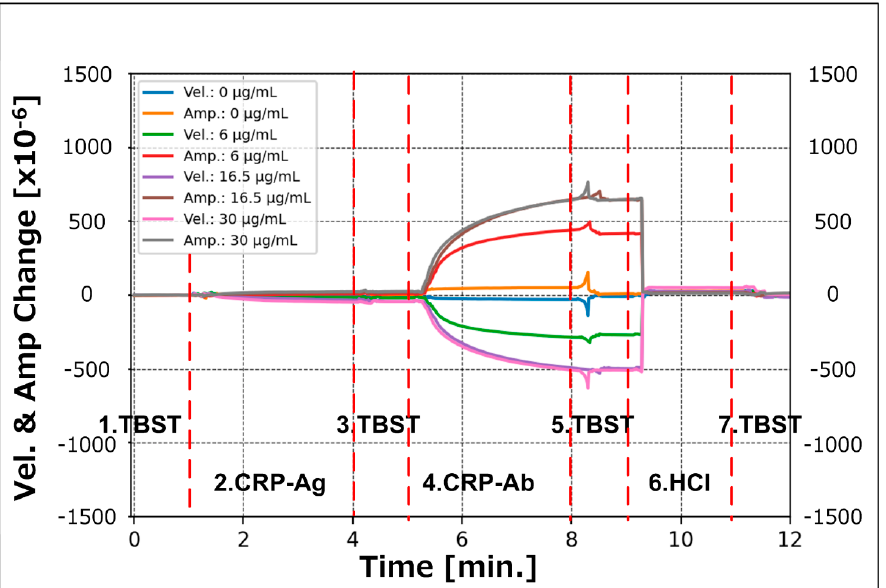
Figure 6. Recorded velocity and amplitude change in a typical measurement cycle.